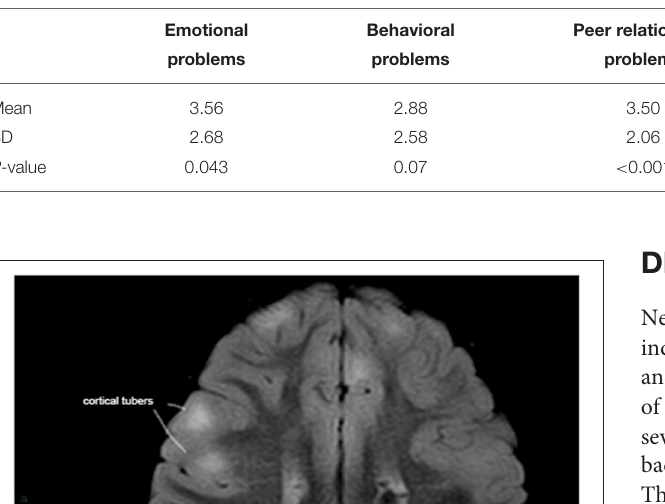
TABLE 4 | Scores of individuals with tuberous sclerosis complex on the Strength and Difficulties Questionnaire (SDQ).